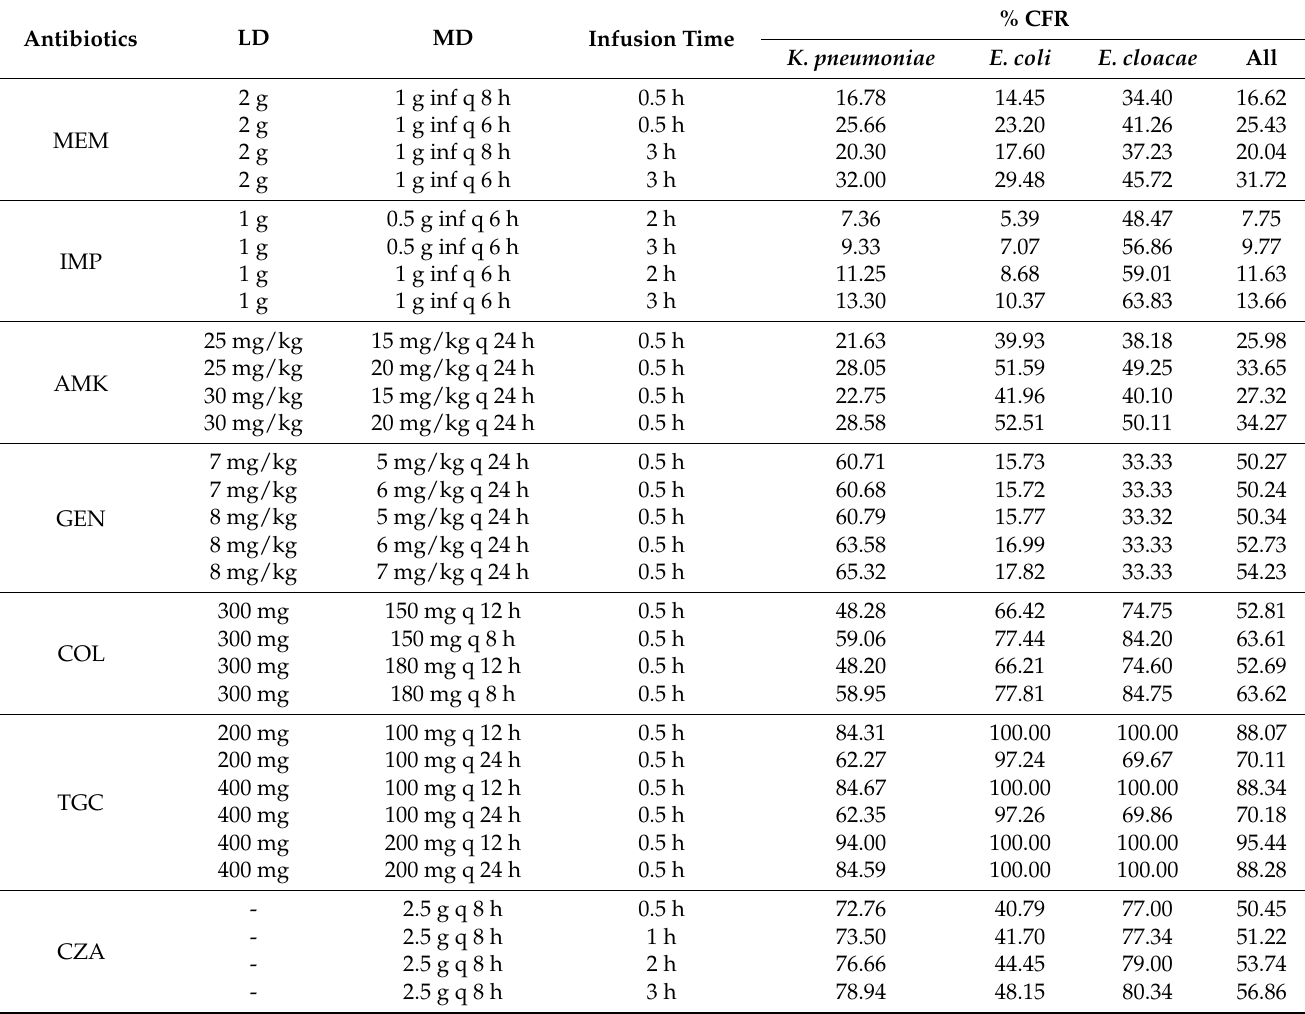
Table 4. Cumulative fraction of response (CFR) of several studied antibiotics grouped by the type of carbapenem-resistant Enterobacterales